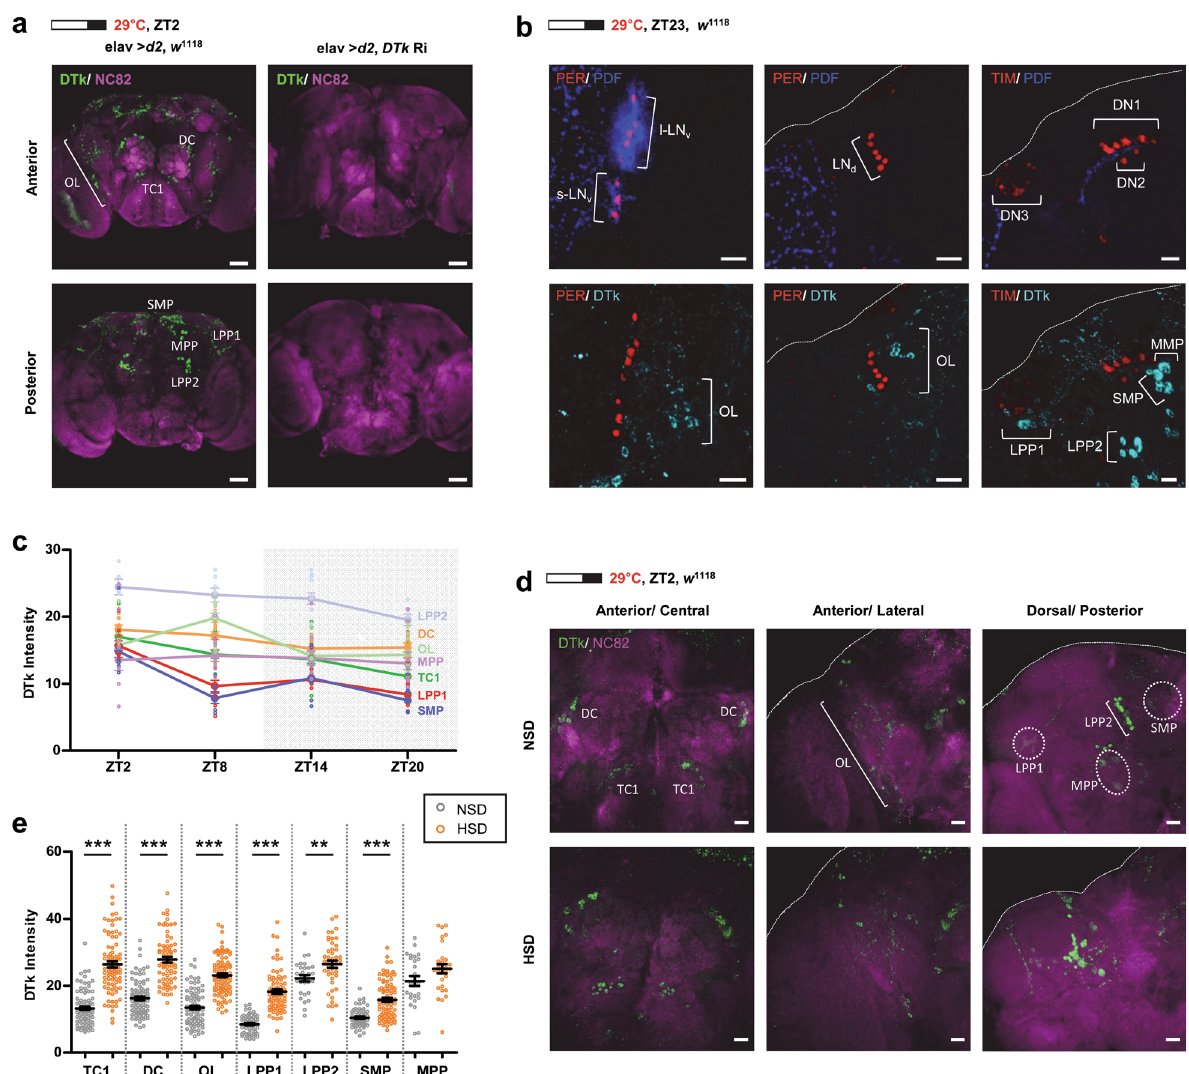
Fig. 4 DTk levels were increased in DTk neurons in fl ies fed a HSD. a Flies of the indicated genotypes were maintained under 16L:8D cycle at 29 °C. Brains were dissected at ZT2 and stained with anti-DTk (green) and anti-NC82 (magenta) antibodies. In control fl ies (elav > d2 , w 1118 ), DTk-positive clusters were observed in DC, TC1, and in the OL on the anterior side. On the posterior side, DTk-positive clusters were observed in the SMP, LPP1, LPP2, and the MPP. DTk-positive clusters were absent in pan-neuronal DTk knockdown fl ies (elav > d 2, DTk Ri). All scale bars represented 50 μ m. b w 1118 fl ies were maintained under a 16L:8D cycle at 29 °C. Brains were dissected at ZT23 and stained with anti-PER (red), anti-TIM (red), anti-PDF (blue), and anti- DTk (cyan blue) antibodies. DTk-positive neurons and clock neurons did not overlap but were in close proximity. All scale bars represented 20 μ m. c w 1118 fl ies were maintained with a NSD and 12L:12D cycle at 29 °C. Brains were dissected at each indicated time and stained with anti-DTk antibodies. DTk intensities of each cluster were quanti fi ed using ImageJ software and are shown. d , e w 1118 fl ies were maintained with a NSD or HSD under a 16L:8D photoperiod at 29 °C. Brains were dissected on day 7, ZT2, and stained with anti-DTk (cyan blue) and anti-NC82 (magenta) antibodies. All scale